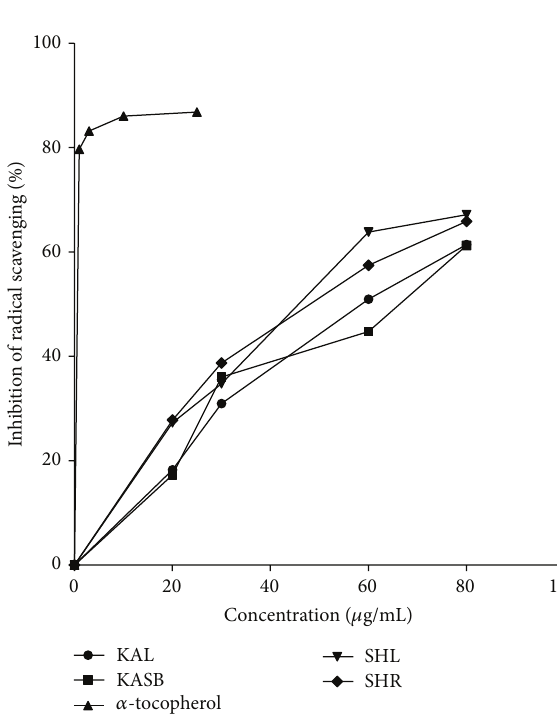
Figure 5: Free radical scavenging activities of methanol leaf extract (KAL) and stem bark extract (KASB) of K. africana and leaf extract (SHL), root extract (SHR) of S. hispidus and 𝛼 -tocopherol (reference antioxidant) determined by DPPH method.